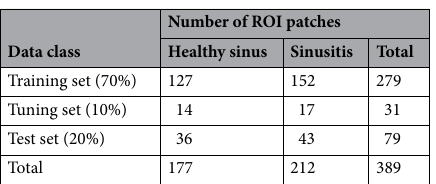
Table 2. The composition of internal paranasal X-ray